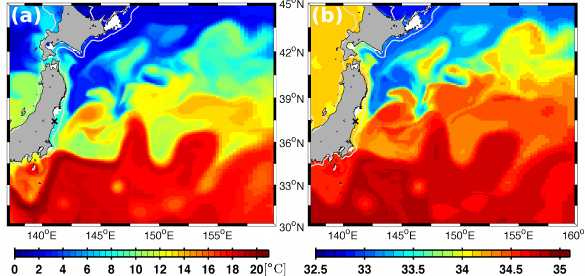
Fig. 11. Simulated sea surface temperature and salinity on 1 April of the nominal year 1993 (panel (a) and (b) , respectively).